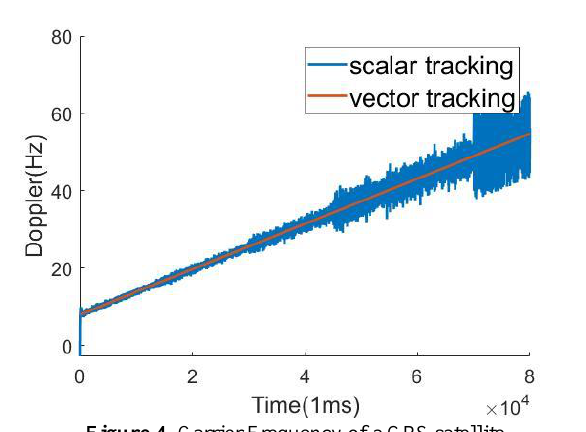
Figure 4. Carrier Frequency of a GPS